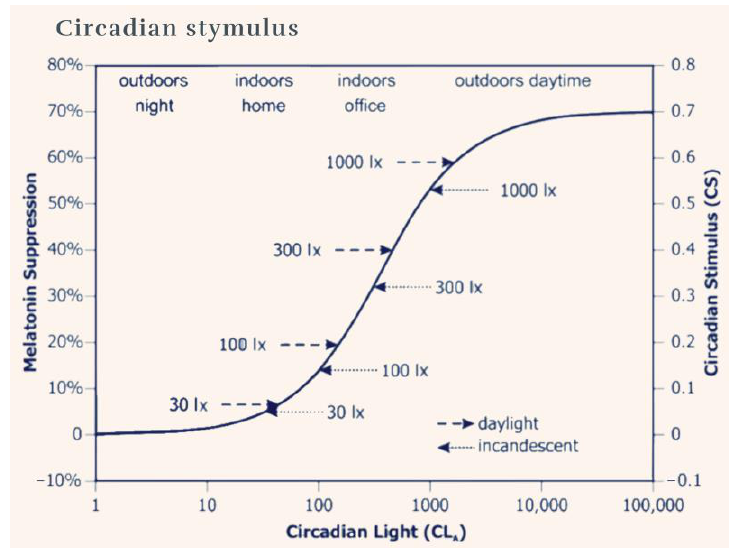
Figure 3. Circadian stimulus.